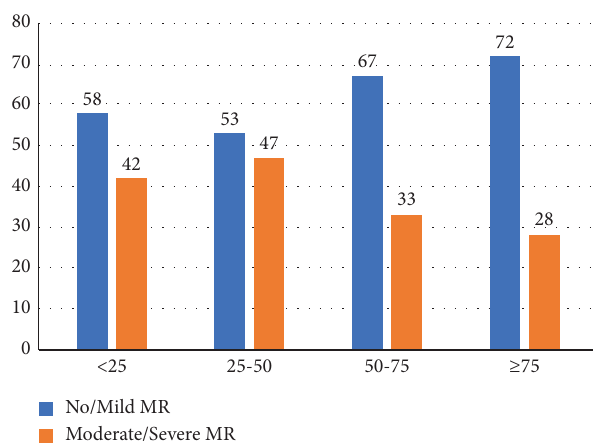
Figure 3: Procedural success/failure distribution across KCCQ groups. X -axis-KCCQ groups, Y -axis-a percentage of patients according to mitral regurgitation who report low KCCQ scores even without signifcant MR.